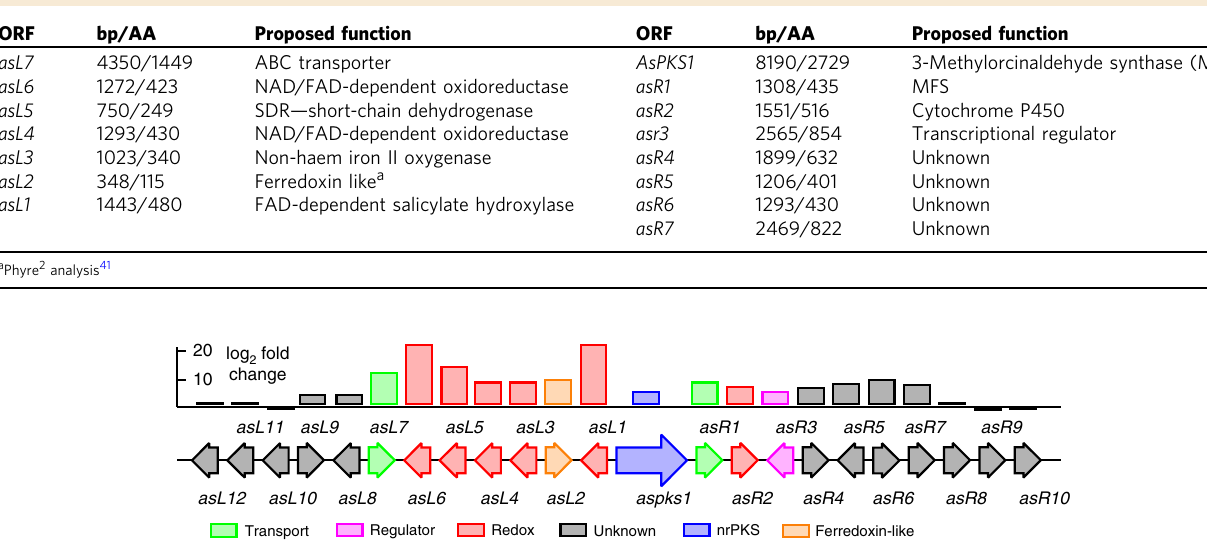
substituted in the usual way, and chemical shift analysis con fi rmed the presence of the tetrahydrofuran ring and loss of the cyclopentenone ring in comparison to 1 . HMBC correlations, particularly from H-12 and H-15 to lactone carbonyl C-16, and from H-13ab to carboxylic acid C-17 con fi rmed the structure.